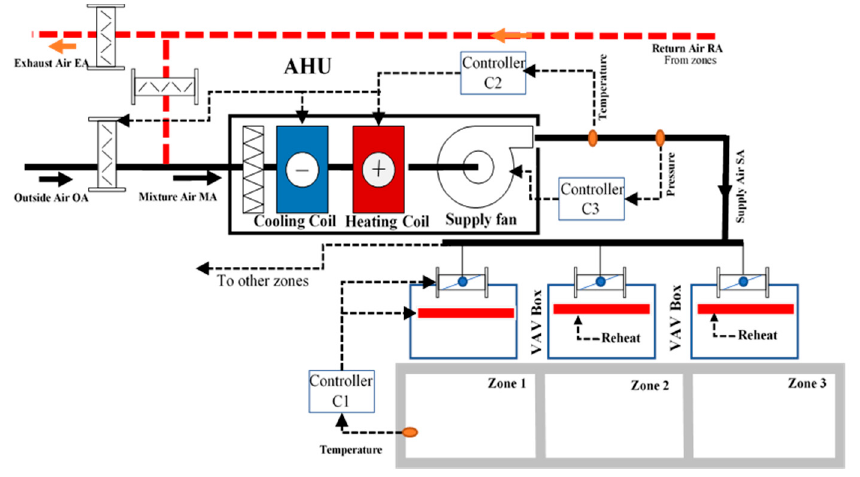
Figure 1. Schematic of single VAV system configuration [9].